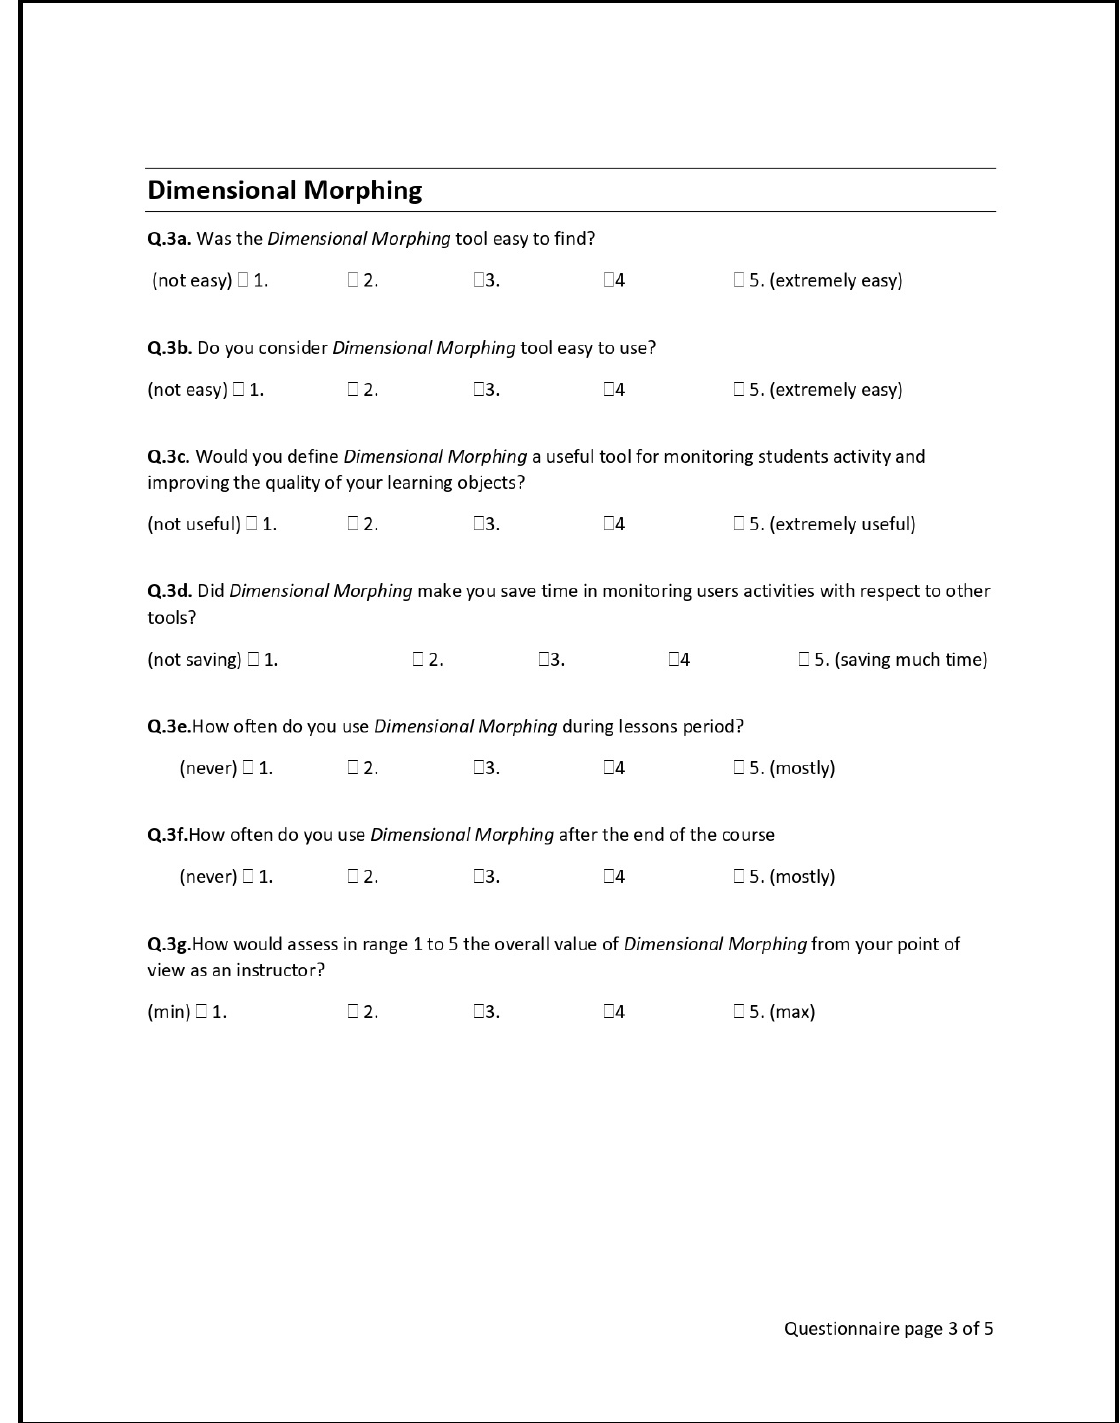
Figure A3. Questionnaire page 3 of